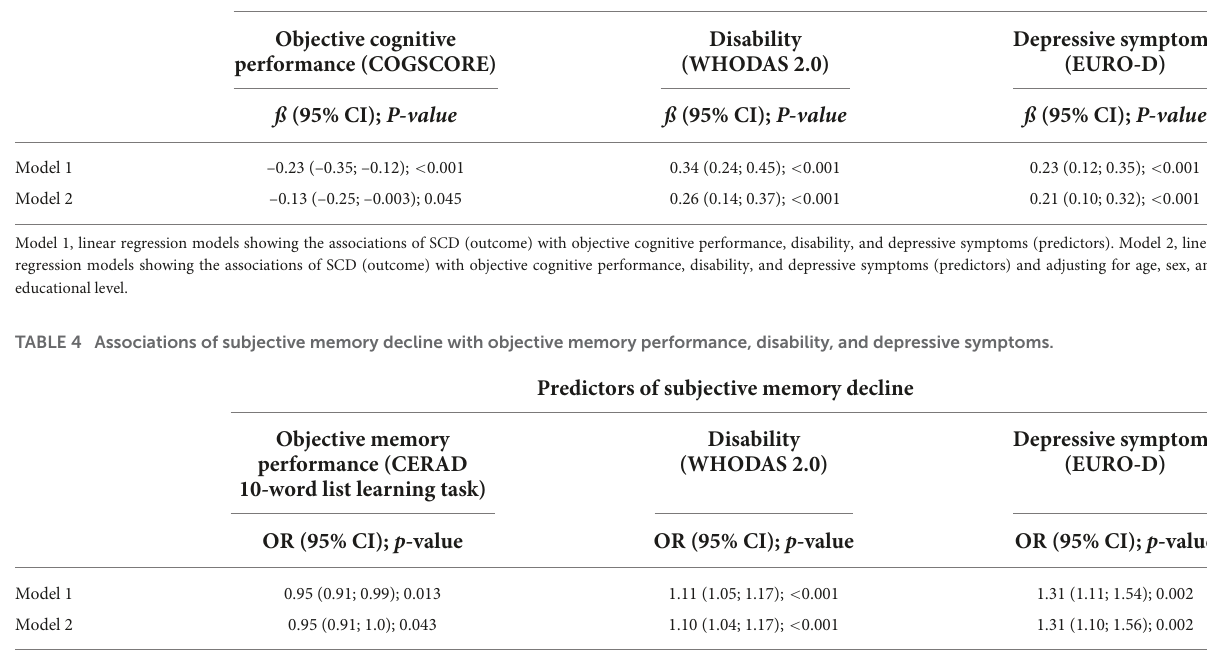
TABLE 3 Associations of subjective cognitive decline with objective cognitive performance, disability, and depressive symptoms.